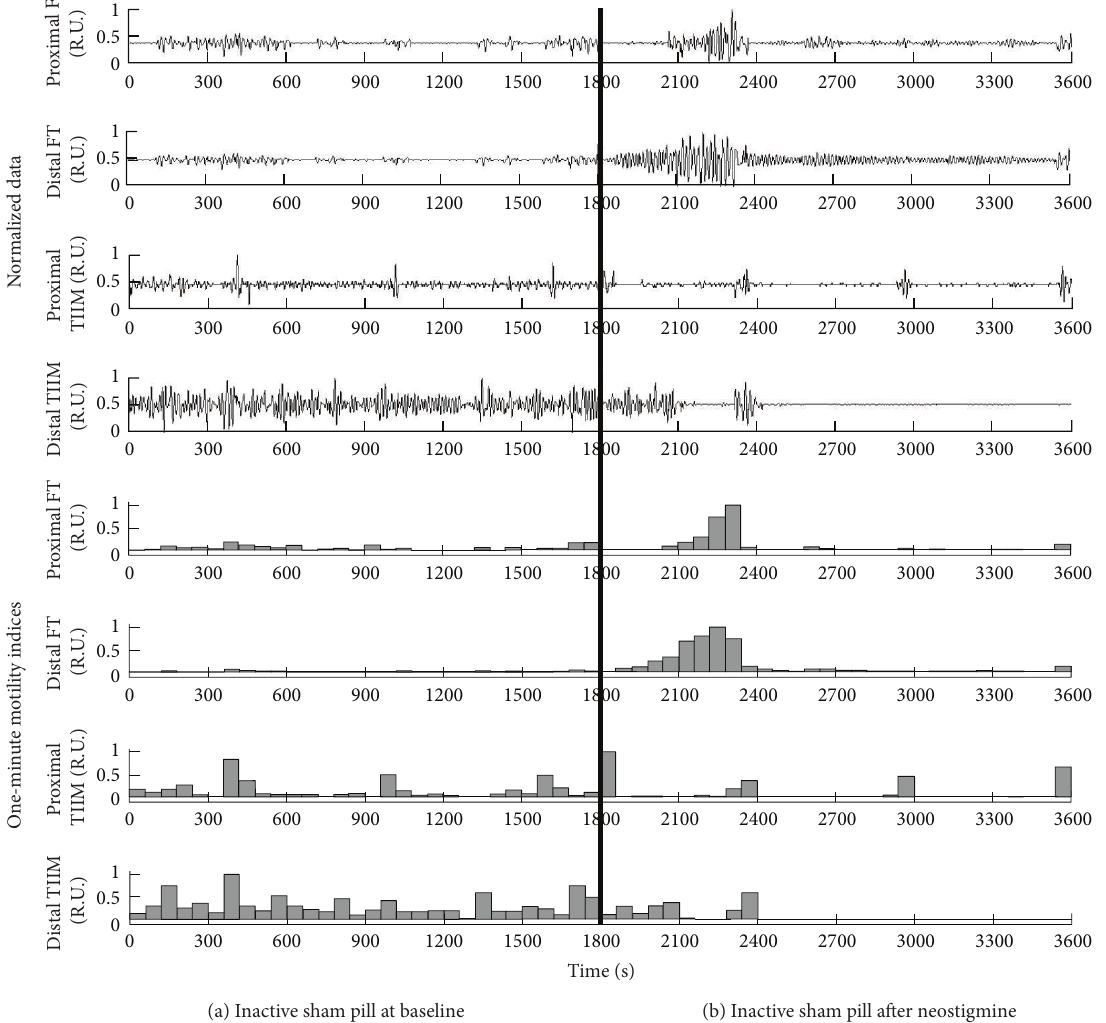
Figure 5: Combined plot of the raw signals and the 1-minute motility indices for an inactive pill in the baseline state (seconds 0–1800) and after the administration of neostigmine (seconds 1800–3600). The 1-minute duration for the administration of neostigmine is denoted by a thick vertical